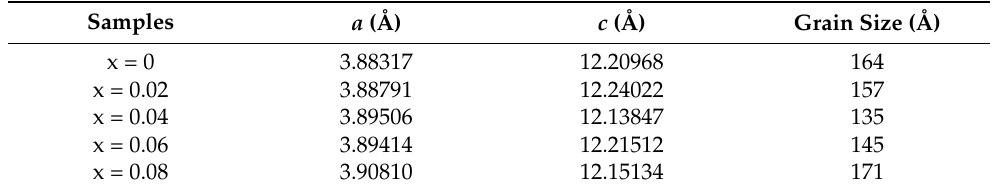
Table 1. Lattice constants and crystallite sizes of Bi 2 − x Ta x O 2 Se (x = 0, 0.02, 0.04, 0.06, and 0.08) ceramics.